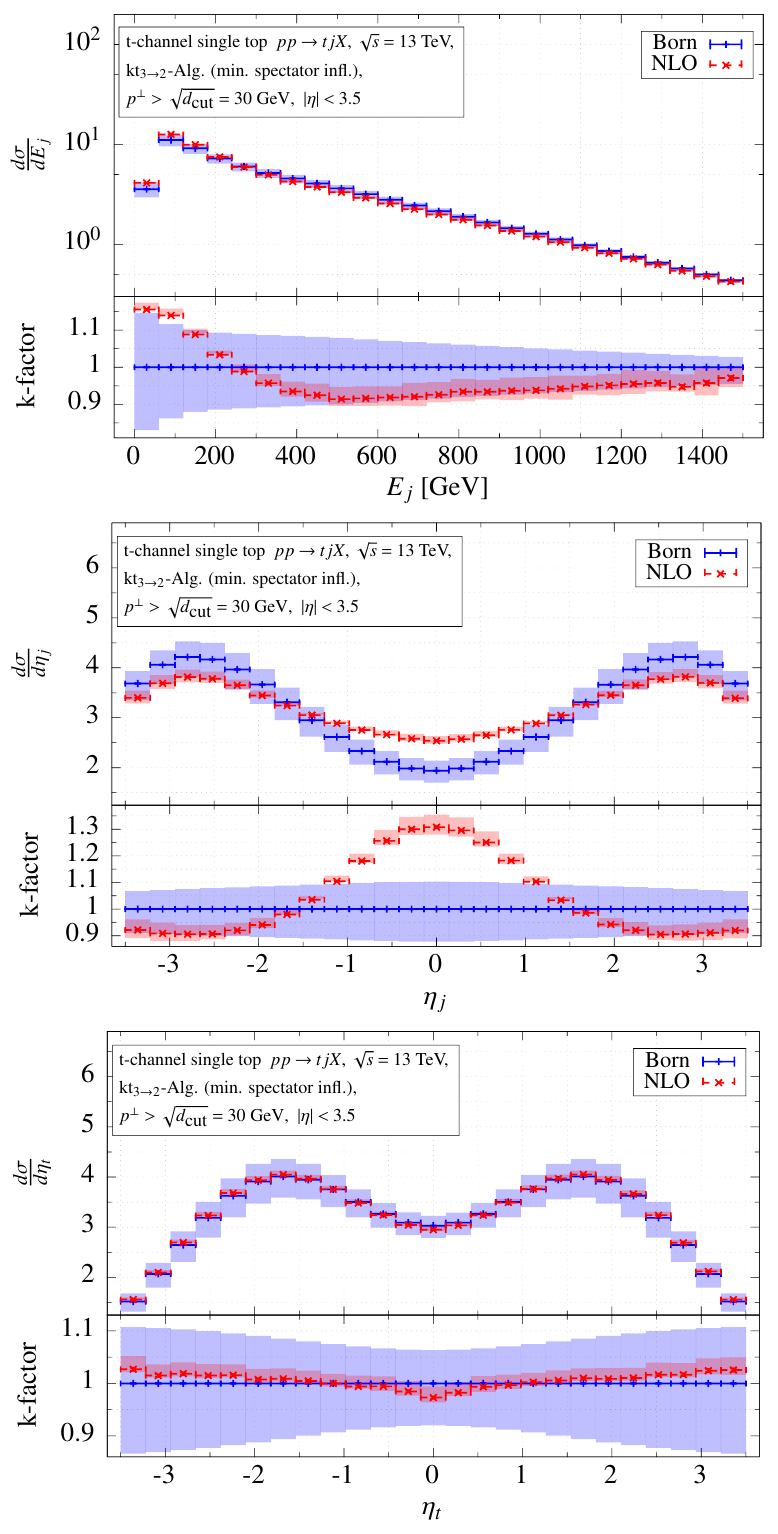
Figure 30 . Same as (cid:12)gure 28 but for the inclusive event